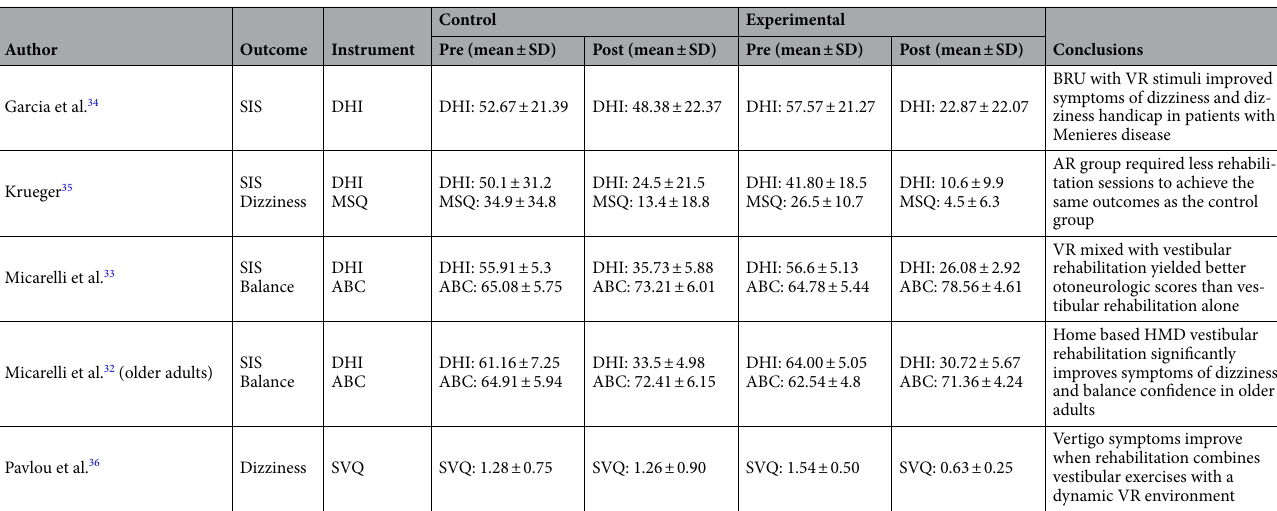
Table 3. Study results for quality of life, balance, dizziness, dynamic gait, vestibular ocular reflex gain and psychological outcome measures. ABC activities specific balance confidence scale, AR augmented reality, BRU balance rehabilitation unit, DHI dizziness handicap score, HMD head mounted display, MSQ motion sensitivity quotient, SVQ situational vertigo questionnaire, SD standard deviation, SIS symptom index score, VR virtual